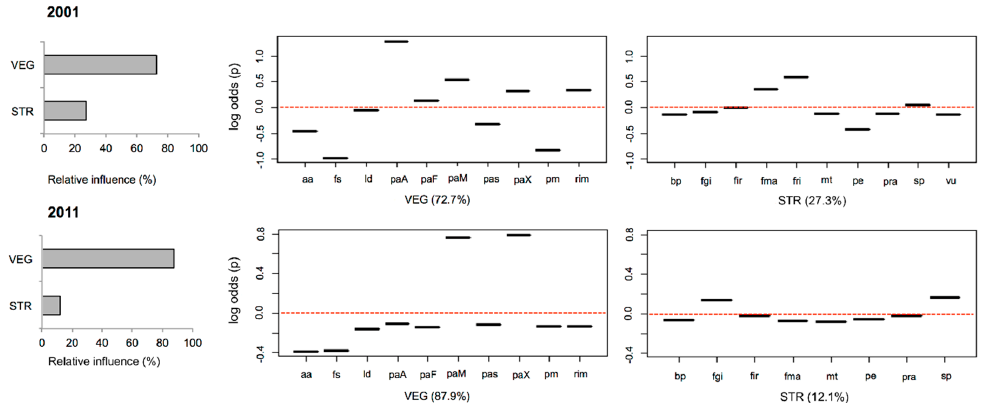
Figure 3. Relative influence of habitat canopy (VEG) and structure (STR) and relationship of each habitat category with capercaillie summer occurrence in 2001 and 2011 in a generalized boosted regression model obtained by integrating out all the other categories. A logistic regression was used, and y-axes report the fitted values on log-odds scale. The red line corresponds to a probability of 0.5 (odds (p) = 1, log odds (p) = 0). Explanatory variables, with their codes, are reported in Table 1. Moreover, in both years, spruce forests (paA, paF, paM, paX) showed a positive influence on capercaillie presence, while fir (aa) and beech (fs) forests were avoided. No important changes occurred between 2001 and 2011 (Figure 3). Habitat structure types (i.e., development stages) did not show a clear pattern considering both years. In 2001 there was an indicative positive relationship of the presence of capercaillie with mature (fma) and over-mature (fri) stands, while pole dense canopies (pe) had a negative impact.